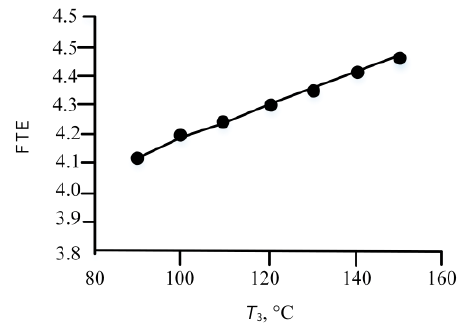
Fig. 5. Variation of FTE with temperature.